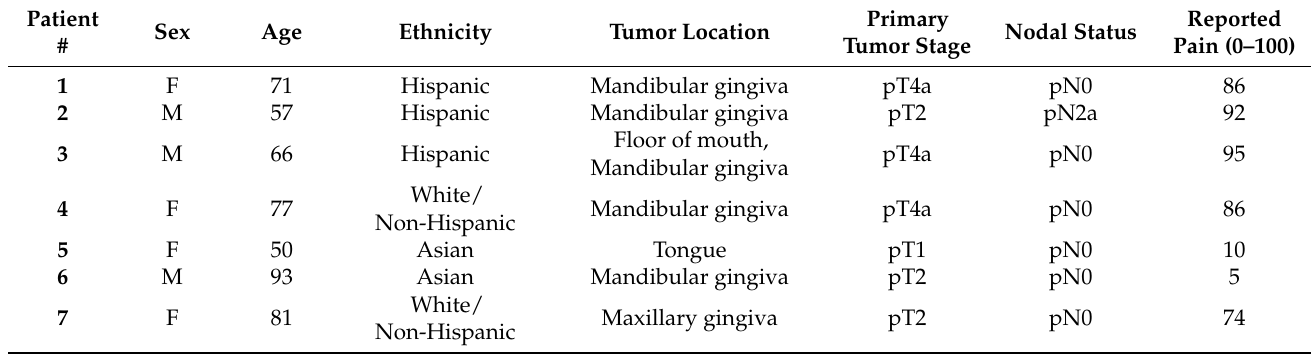
Table 1. Demographic, anatomic location and tumor staging for patients for which cathepsin S activity was measured in oral SCC and matched normal tissue. Reported pain, as measured by question 7 of the University of California San Francisco Oral Cancer Pain Questionnaire, is provided for each